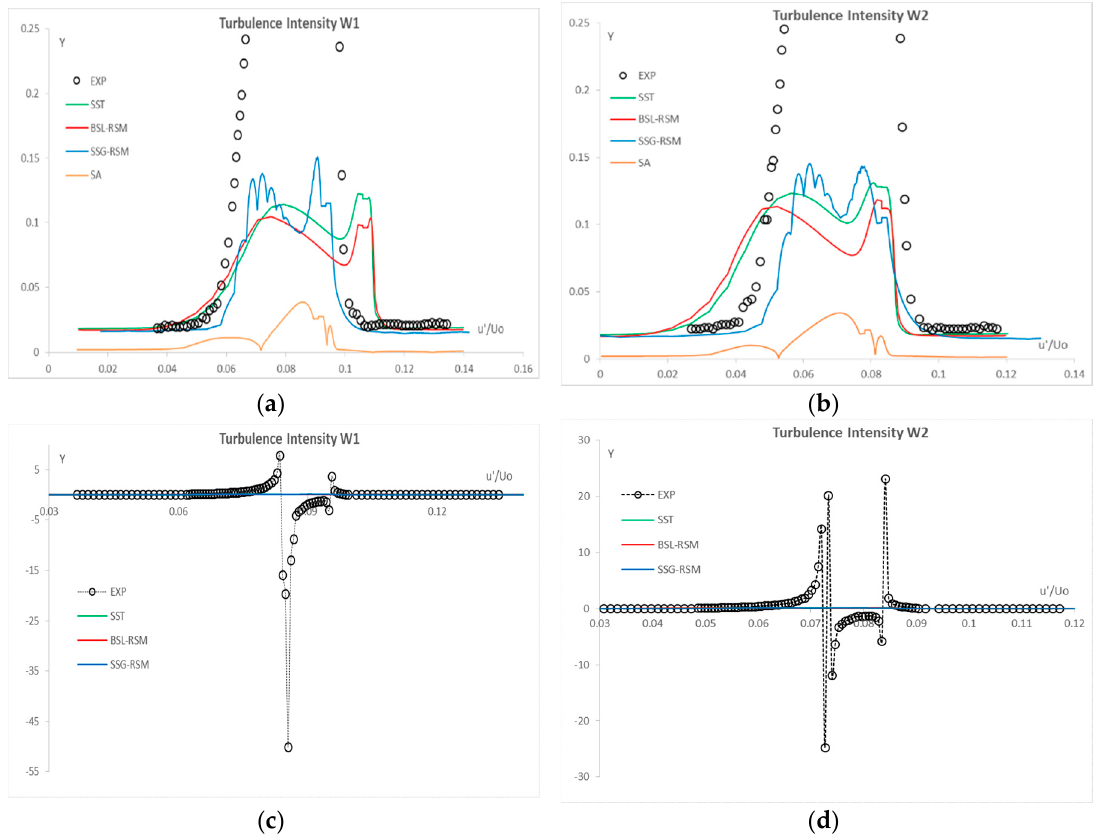
Figure 10. Turbulence Intensity distributions inside the DCA wake (large scales included for the SSG-RSM): ( a , b ) Zoomed regions; ( c , d ) The whole measured range.